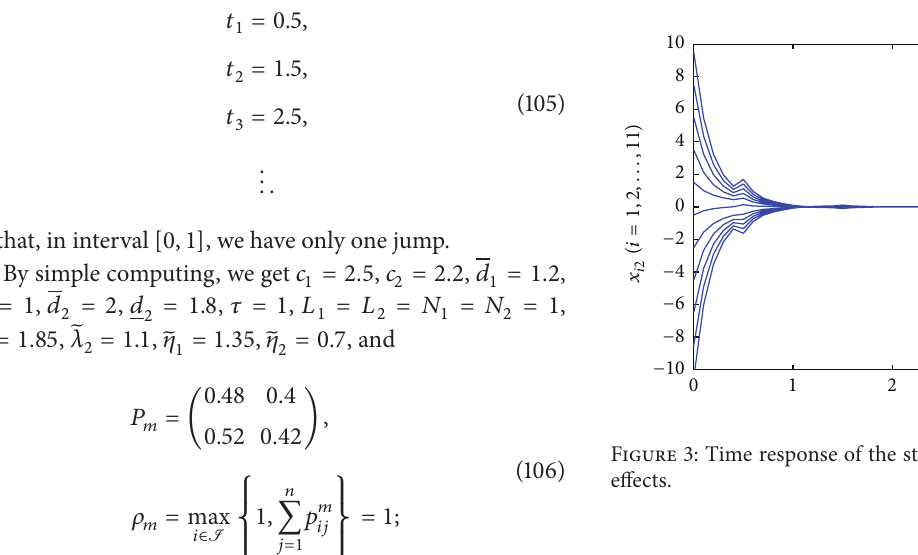
Figure 2: Time response of the state variable 𝑥 1 (𝑡) with impulsive effects.